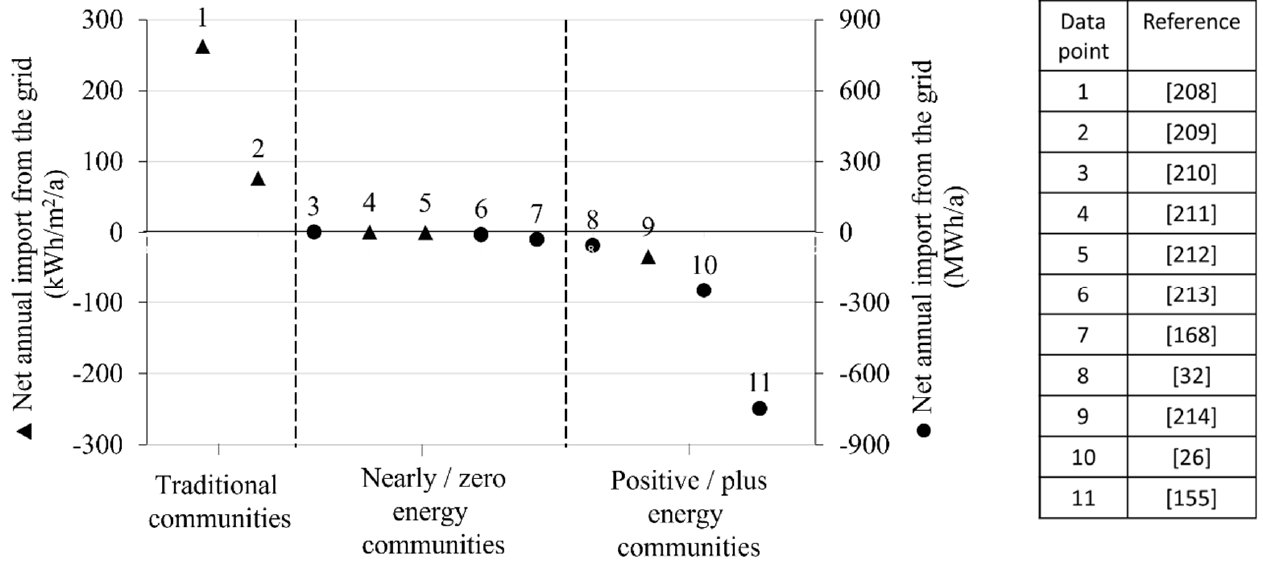
Figure 9. Quantitative comparison of PECs with the traditional communities and zero energy communities .